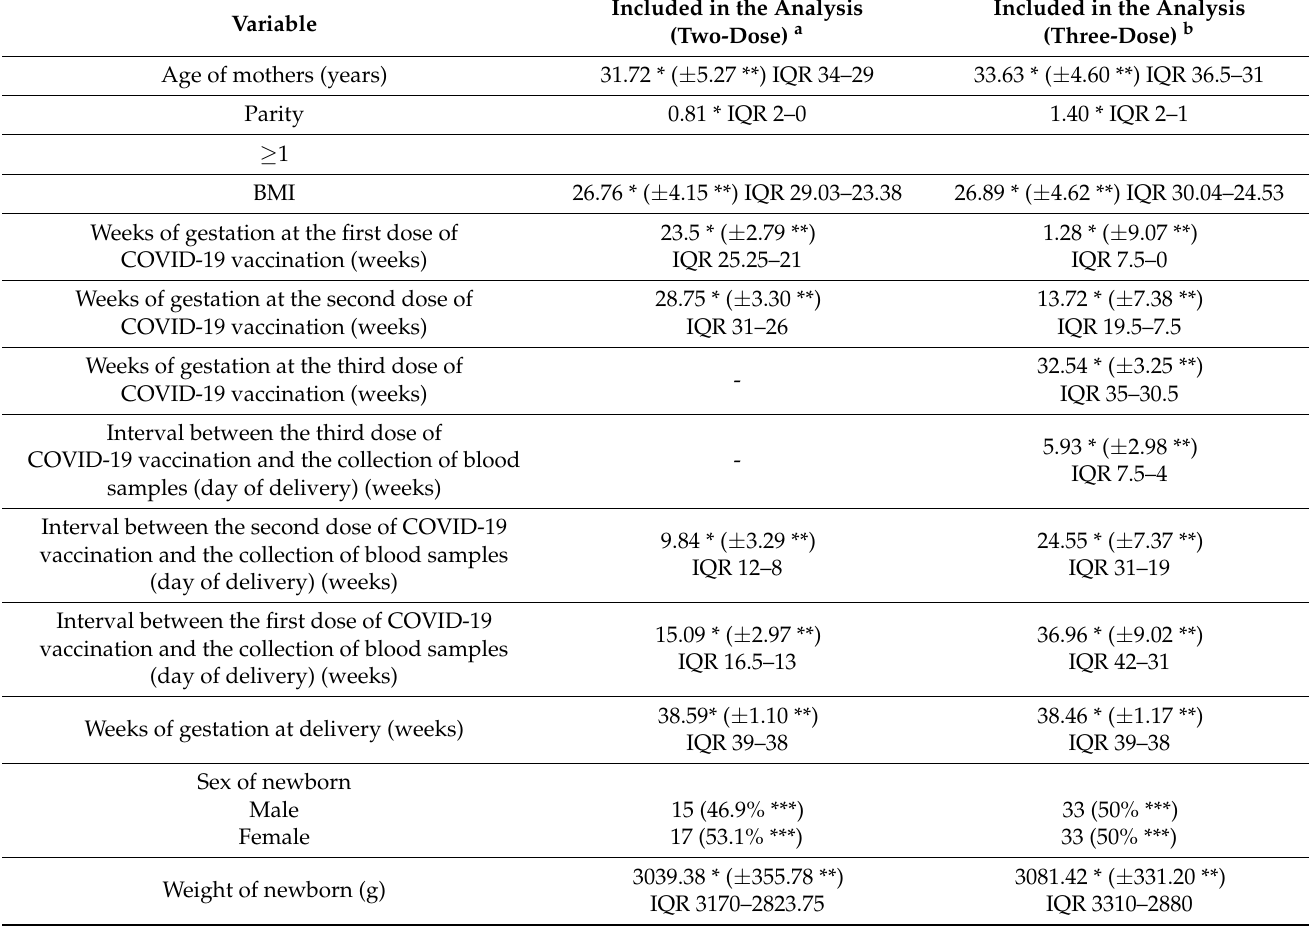
Table 1. Maternal and newborn demographic and clinical